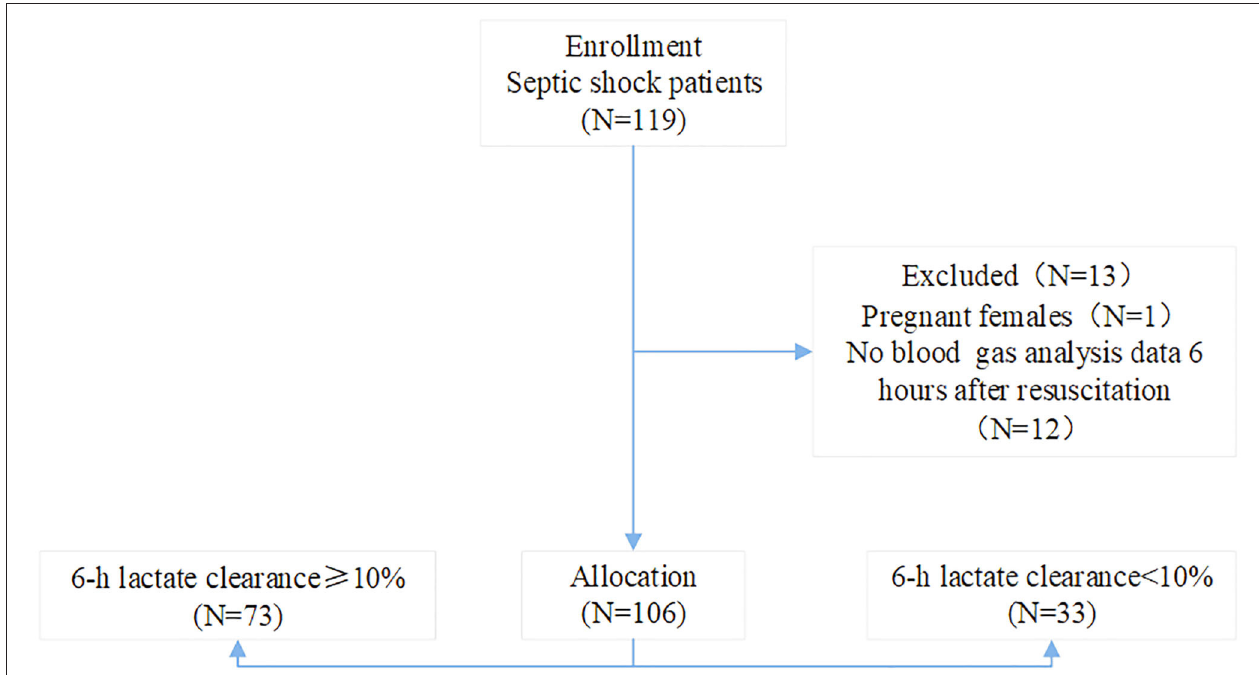
FIGURE 1 | The flowchart of this study on septic shock